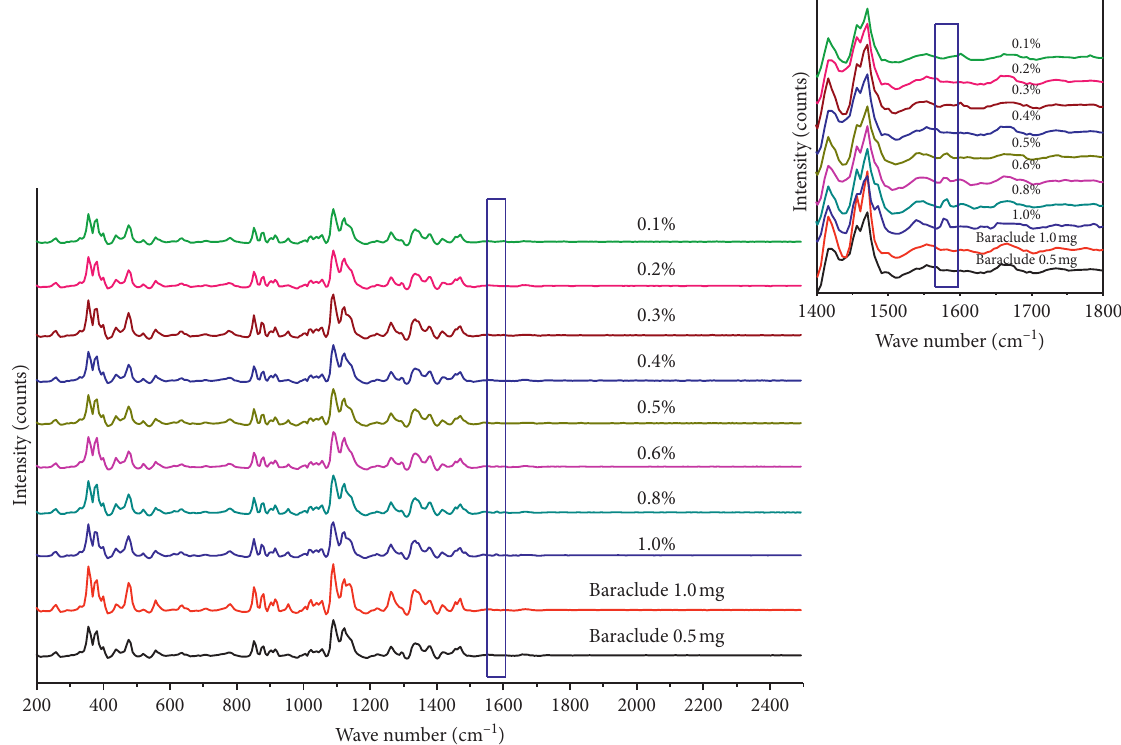
Figure 2: Raman spectra of calibration samples of different API mass concentrations (w/w%) and test set samples (Baraclude tablets and 0.5% w/w%). The blue box shows the intensity change of the Raman peak at 1580cm − 1 .